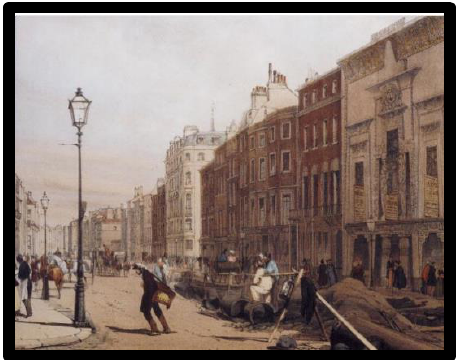
Figure 15: Webb, R. (2001) Installing the sewer system in between the Quadrant Moreover, there were the street sweepers to clean Regent Street that was covered with wood first and then replaced by a granite stone pavement which was believed to be Figure 14: Anonymous (1840-1850), No. 45 Regent Street . safe and more efficient at absorbing the filth (URL 11) (Newton 1839, p.338). Regent Street became Regent Street bodies followed the same a practical and functional by generating a perception of modern and practical living into a practical machine that space. contained mixed-use buildings. Considering As it is seen on Network 3 things that do not seem related to each other are actually connected to one another to create perceptions, memories in space and ANT demonstrates a network that stands for perception generator of the